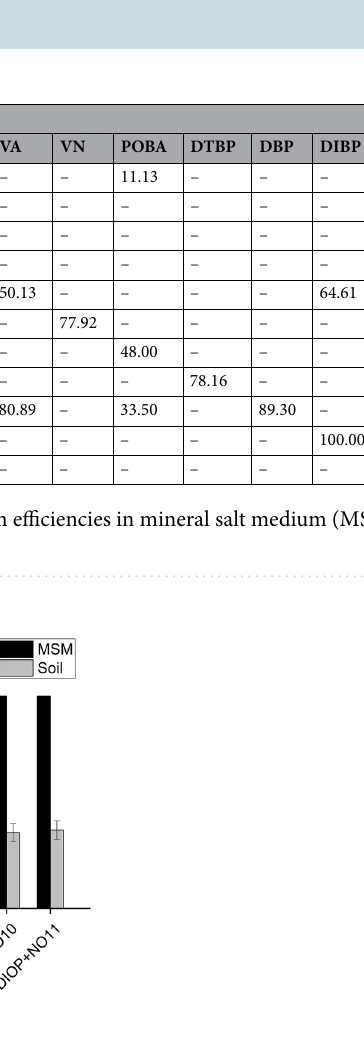
Figure 4. Degradation efficiency of PAs-degrading bacteria in MSM solutions and soil. B4, Bacillus sp. B4 ; D4 Bacillus sp. D4; ED2, Bacillus sp. ED2 ; NO3, Enterobacter sp. NO3; NO13, Bacillus sp. NO13; SD2, Bacillus